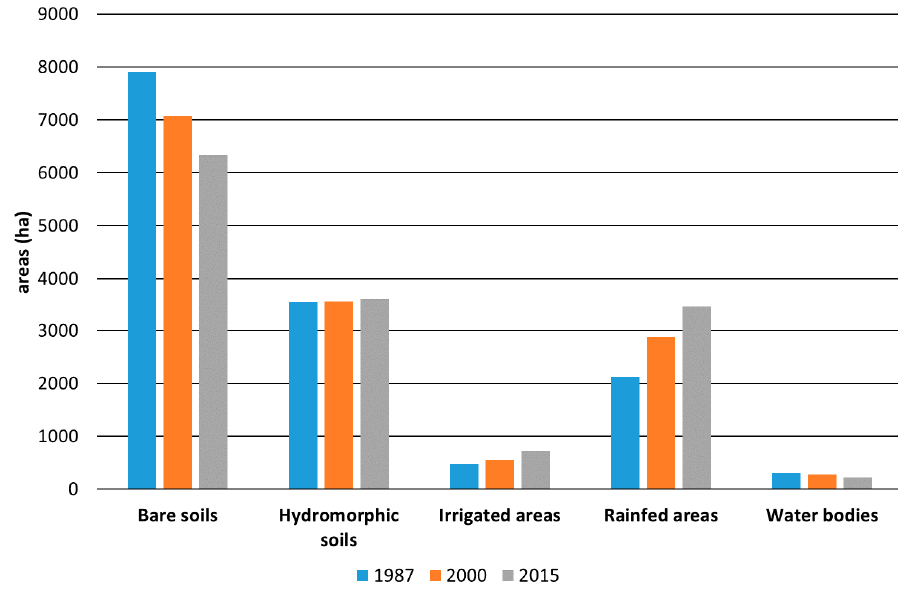
Figure 10. Acreages of LULC classes in 1987, 2000, and 2015 across the Mogtedo region, as determined using Landsat images (this study).